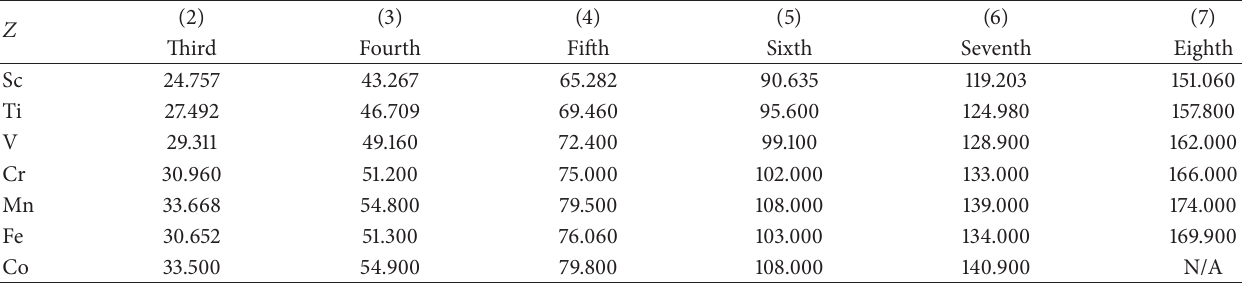
Table 6: Ionization energies (eV) of isoelectronic series from the CRC.